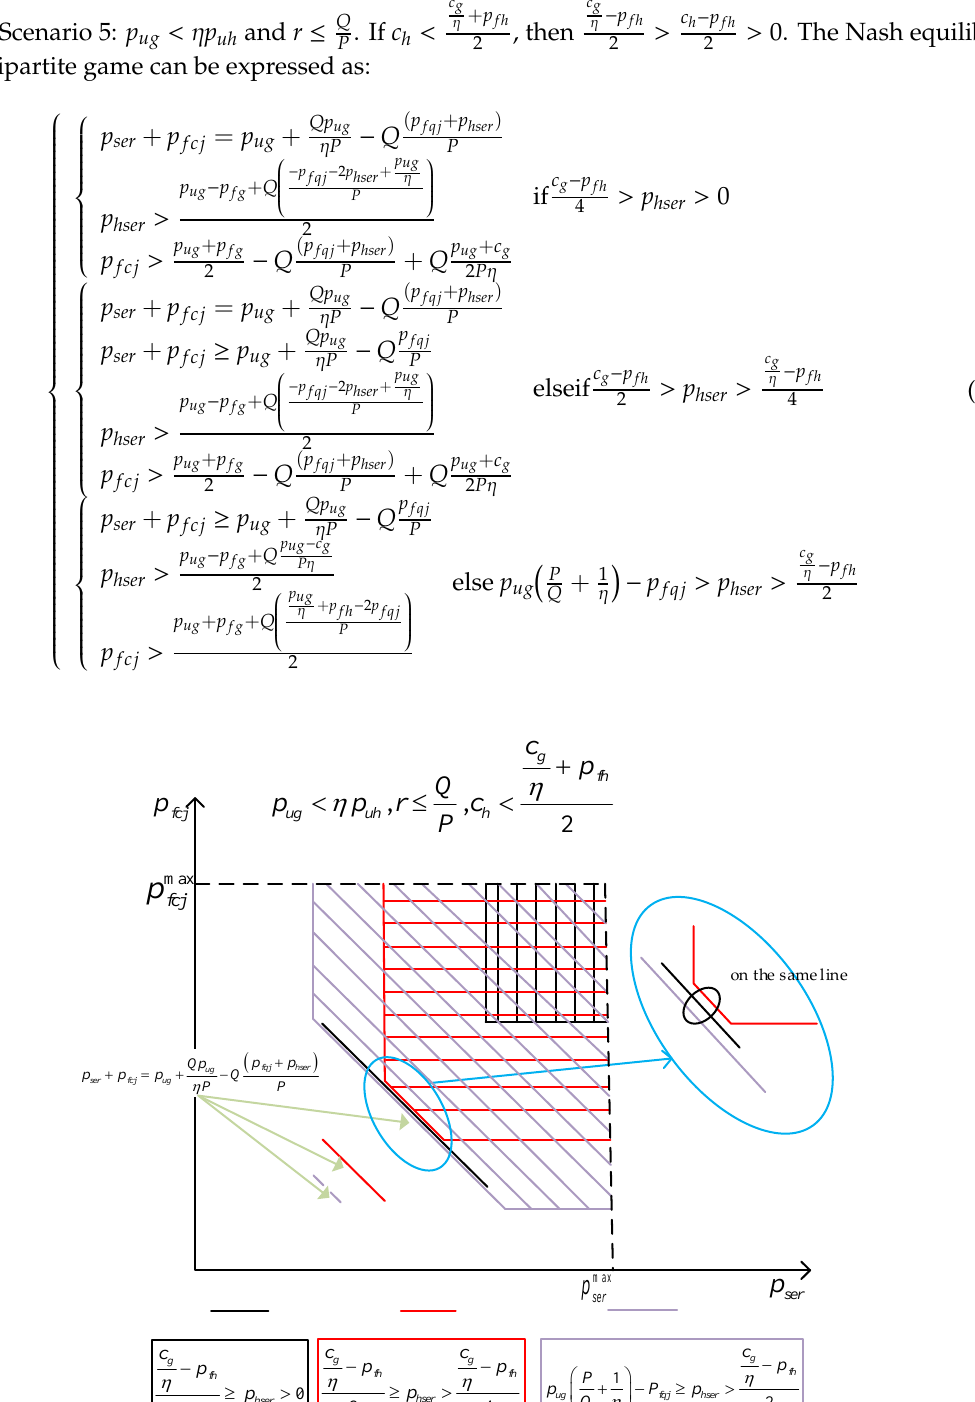
cg cg − p − p η η fh fh < p ≤ , the Nash equilibria of the three-party game 𝑐𝑔 𝑐𝑔 hser 2 4 −𝑝 𝑓ℎ −𝑝 𝑓ℎ 𝜂 𝜂 cg < 𝑝 ≤ − p (cid:16) (cid:17) , the Nash equilibria of the three-party ℎ𝑠𝑒𝑟 η fh > − p ≥ p P + 1 4 2 , η fqj hser Q 2 𝑃 + 1 ) − 𝑝 ≥ 𝑝 > 𝑓𝑞𝑗 ℎ𝑠𝑒𝑟 𝑄 𝜂